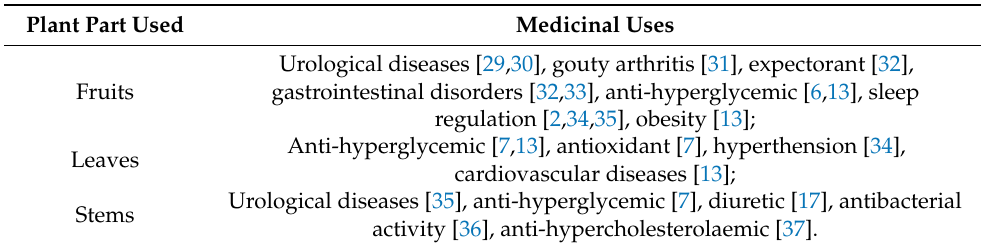
Table 1. Folk medicinal uses of Prunus avium L. fruits and some of their by-products (leaves and